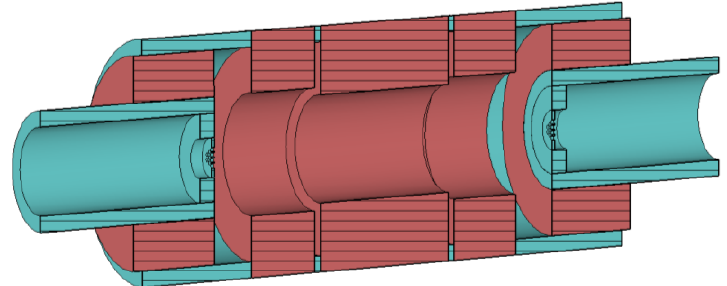
Fig. 5. The design of magnetic system in permanent